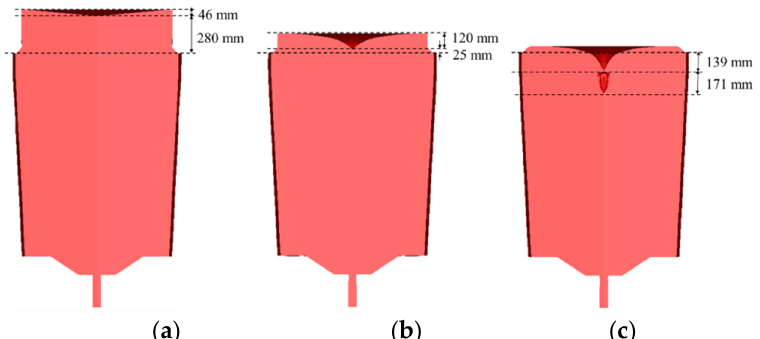
Figure 2. Solidified ingots obtained for ( a ) 16% hot top; ( b ) 8% hot top; ( c ) free hot top.